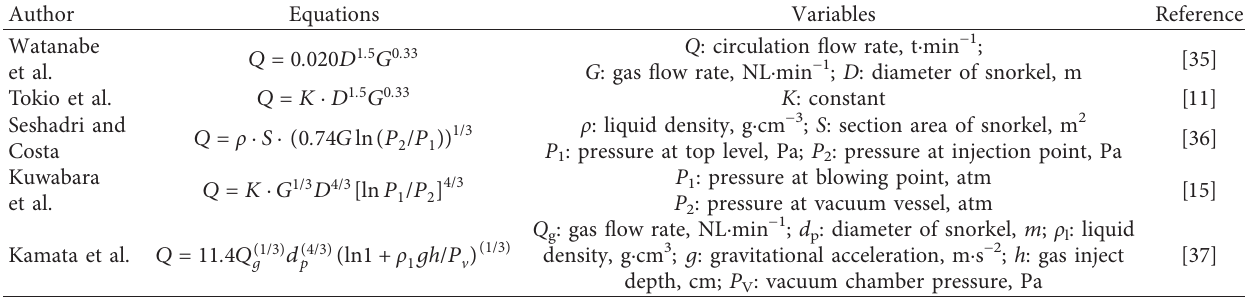
Table 1: Equations for circulation flow rate.